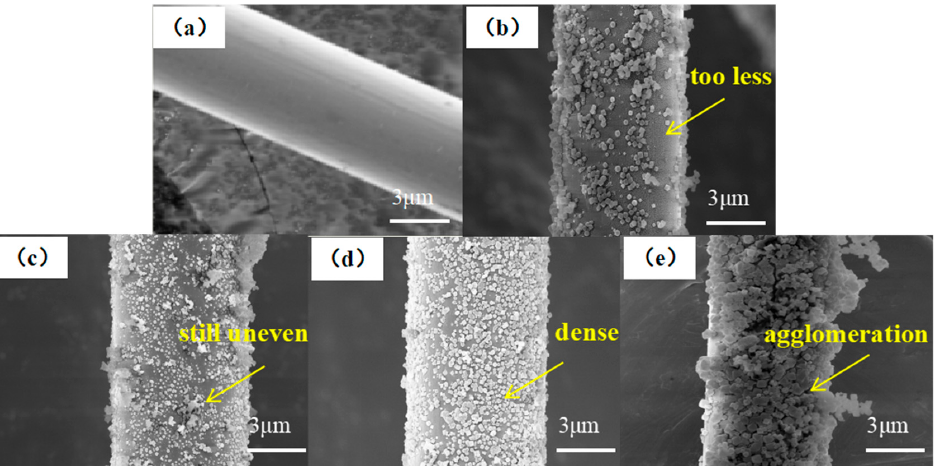
Figure 5. SEM images of MOF/CF: ( a ) CF-COOH; ( b ) MOF/CF-5; ( c ) MOF/CF-7; ( d ) MOF/CF-9; ( e ) MOF/CF-11